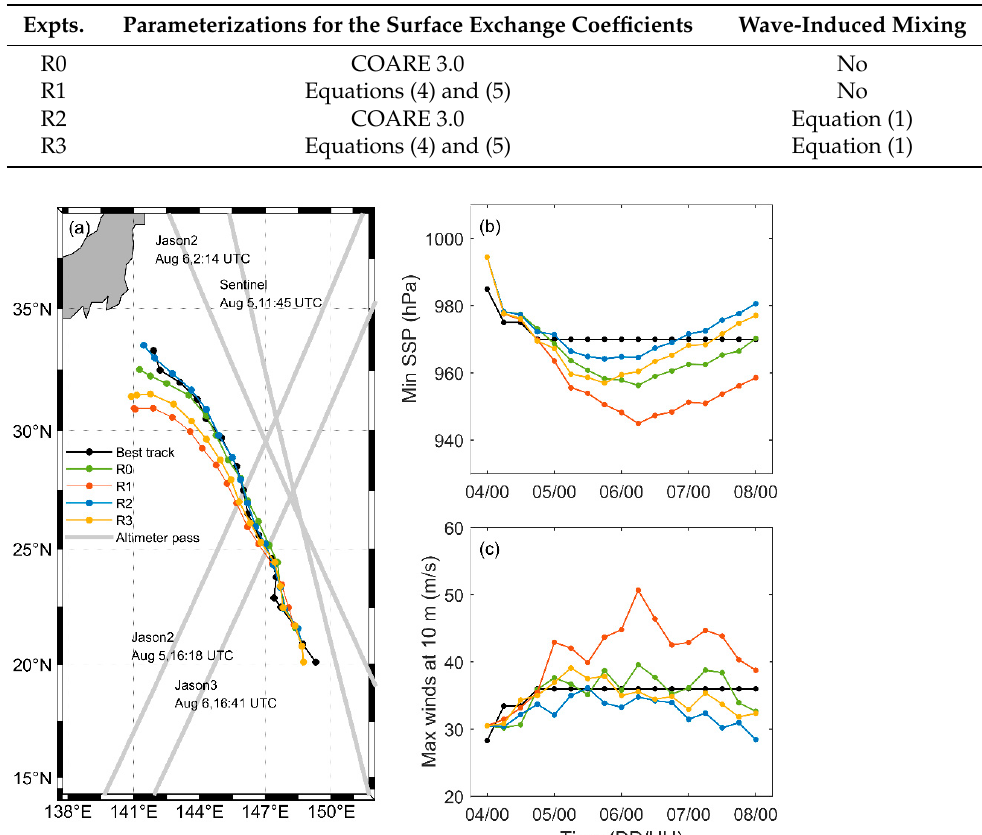
Table 1. Numerical experiment design.